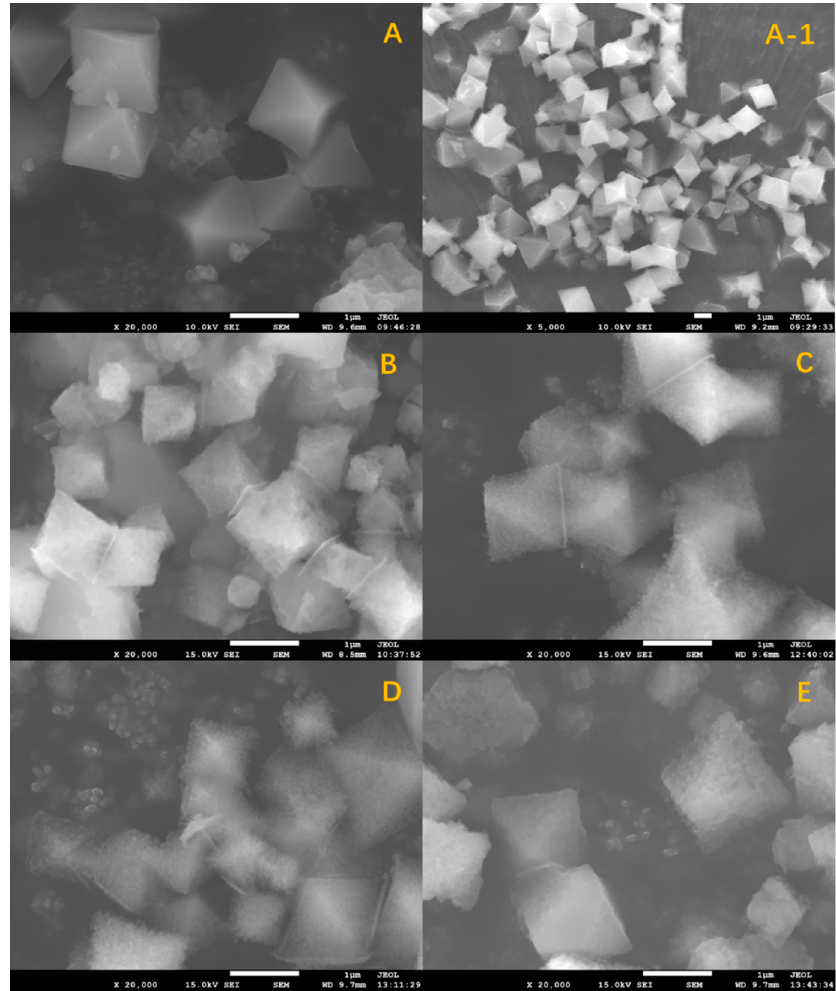
Figure 2. SEM micrographs of as-prepared MIL-101(Fe) and activated samples. ( A ) M-0, at magnifications of 20,000 × ; ( A - 1 ): M-0, at magnifications of 5000 × ; ( B ) M-120, at magnifications of 20,000 × ; ( C ) M-150, at magnifications of 20,000 × ; ( D ) M-170, at magnifications of 20,000 × ; ( E ) M-200, at magnifications of 20,000 × .